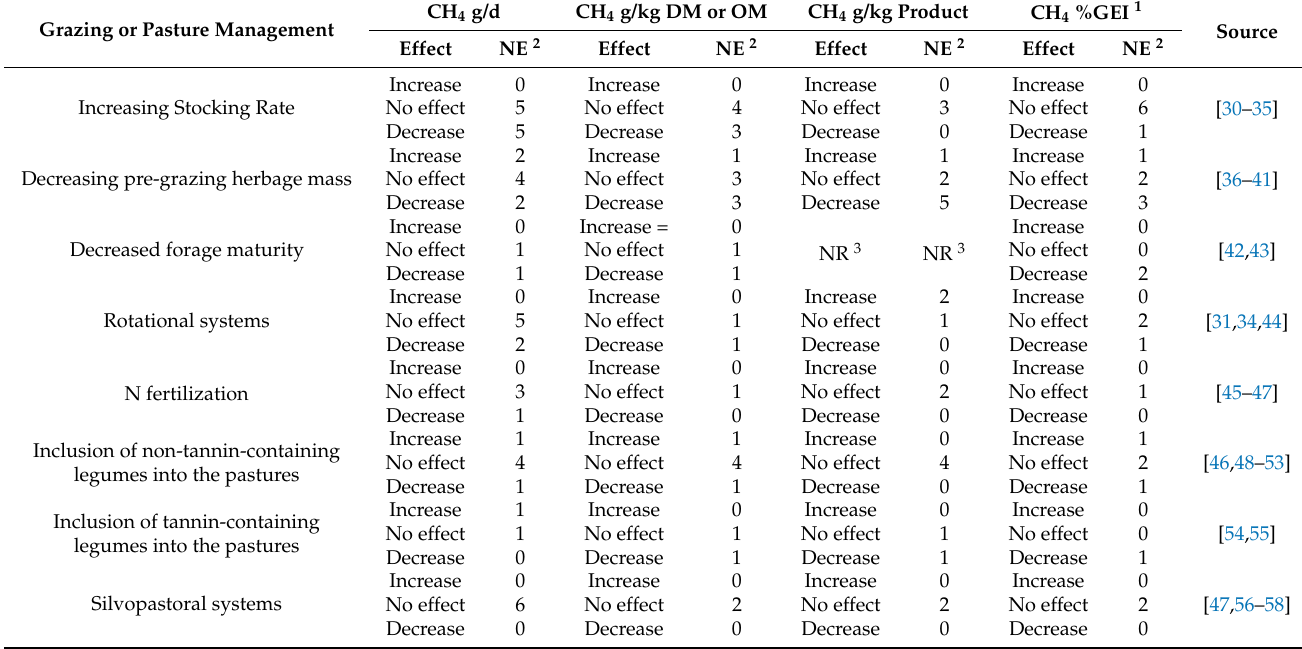
Table 1. Number of experiments that reported either increased, decreased, or not modified CH 4 emissions when implementing different grazing management